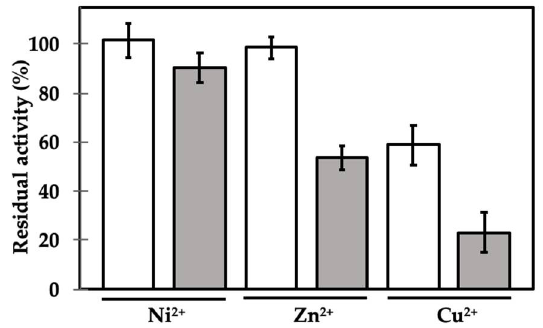
Figure 4. Incubation of GH2 β -mannosidase in the absence (white bars) and in the presence of γ C at a molar ratio of 1:1 (gray bars), with 1 mM Ni 2 + , Zn 2 + and Cu 2 + . Residual enzyme activity is expressed as percentage activity compared with the enzyme alone by using pNP- β - d -mannopyranoside as the substrate. Each point is the mean of three assays.